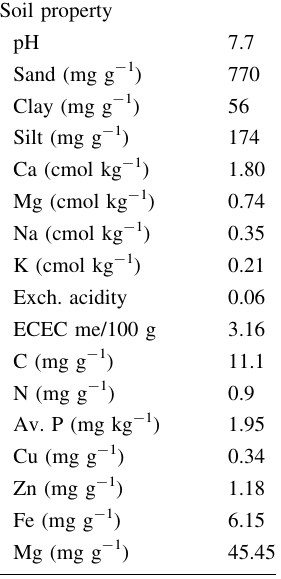
Table 1 Pre-cropping physical